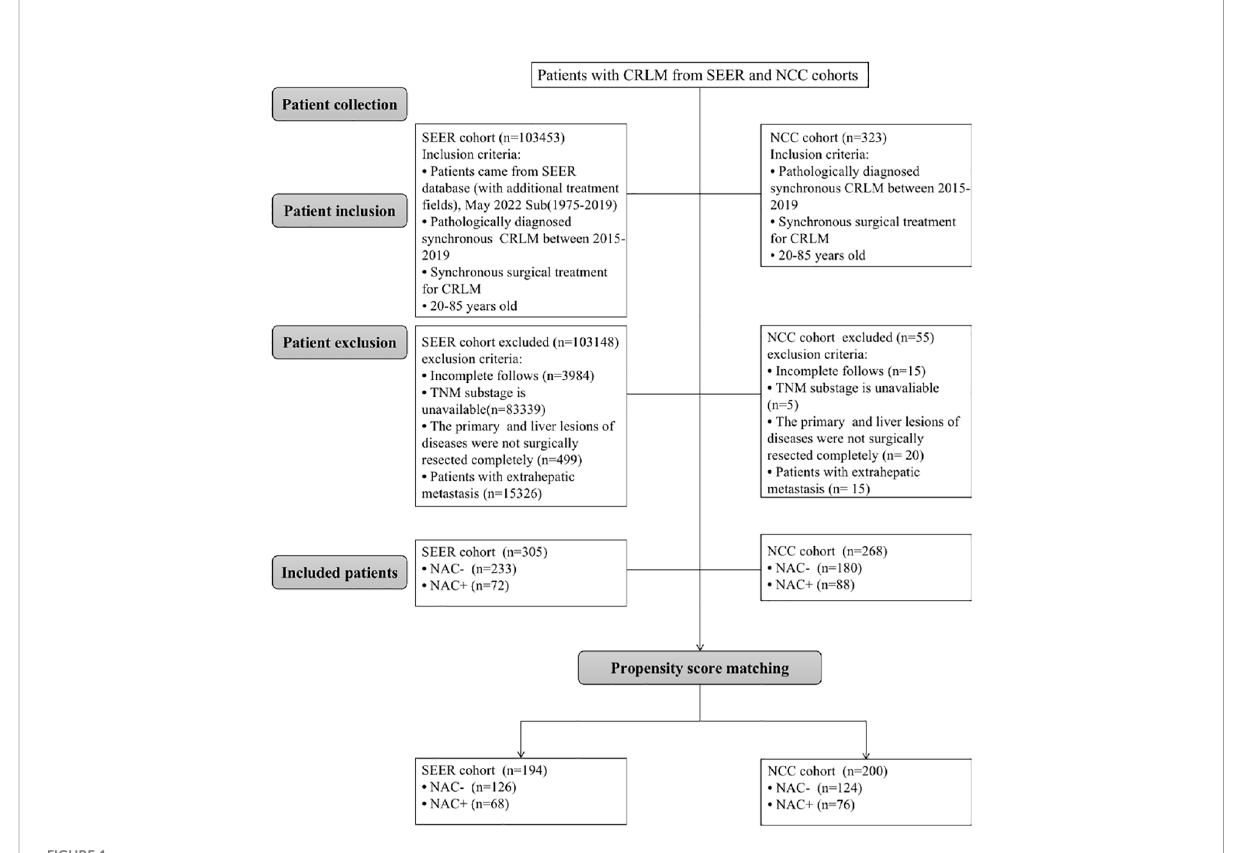
FIGURE 1 Flow diagram of the